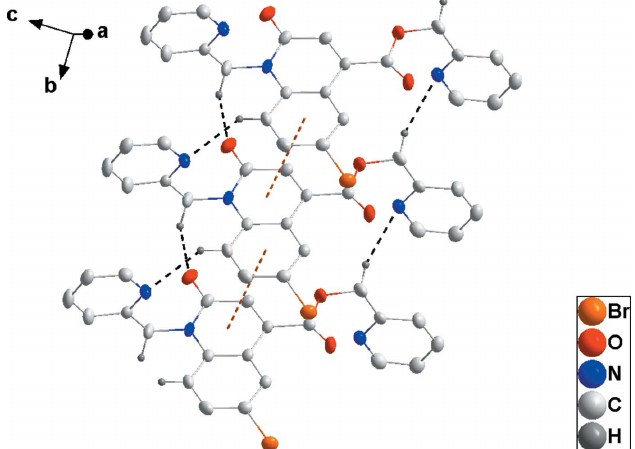
Figure 2 A portion of one stack of molecules showing the C—H (cid:3)(cid:3)(cid:3) O and C— H (cid:3)(cid:3)(cid:3) N hydrogen bonds as black dashed lines and the (cid:2) – (cid:2) stacking interactions as orange dashed lines.